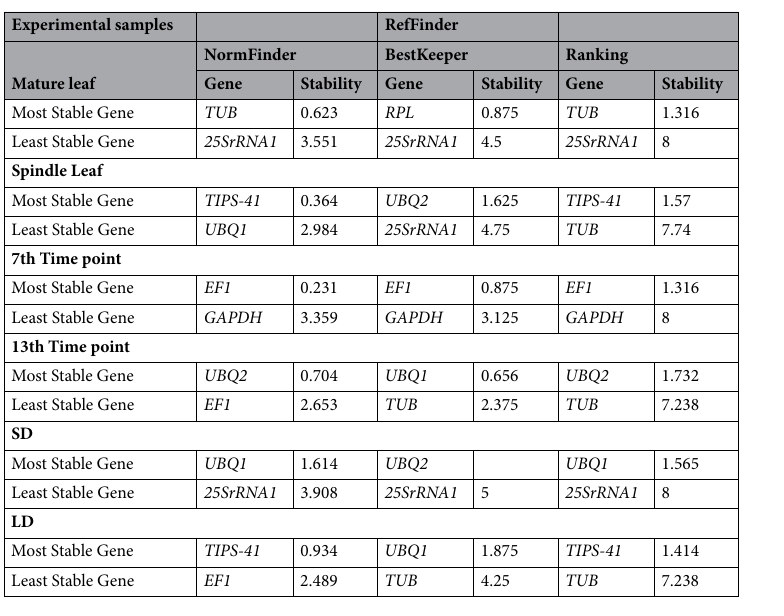
Table 4. Summarized data from RefFinder Algorithm in different experimental samples. Complete data is available in Supplementary Table S3